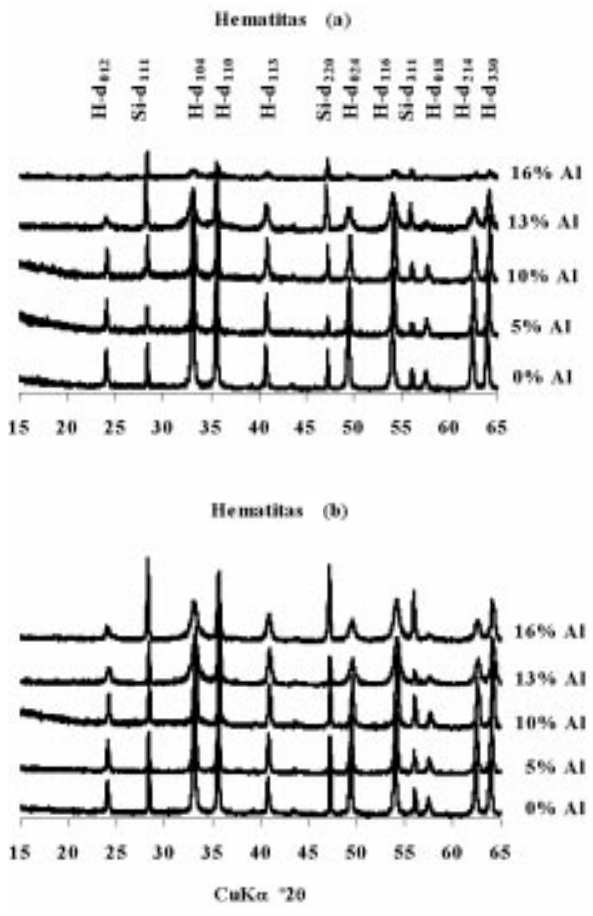
Figura 1. Difratogramas de raio-X (DRX) para as hematitas (H) com adição de silício (Si), antes (a) depois (b) do tratamento com oxalato ácido de